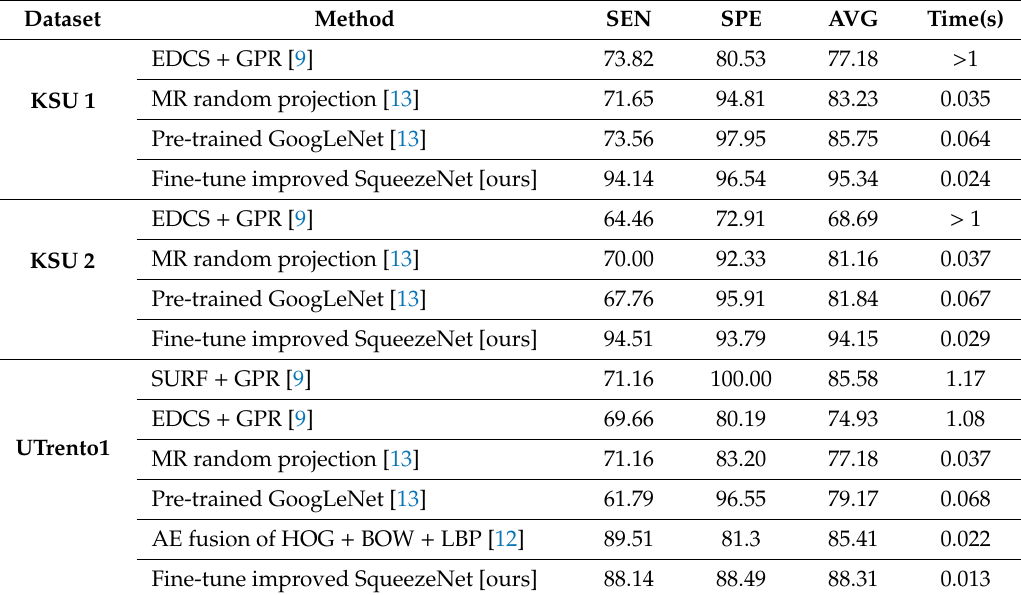
Table 2. Comparison to state-of-the-art